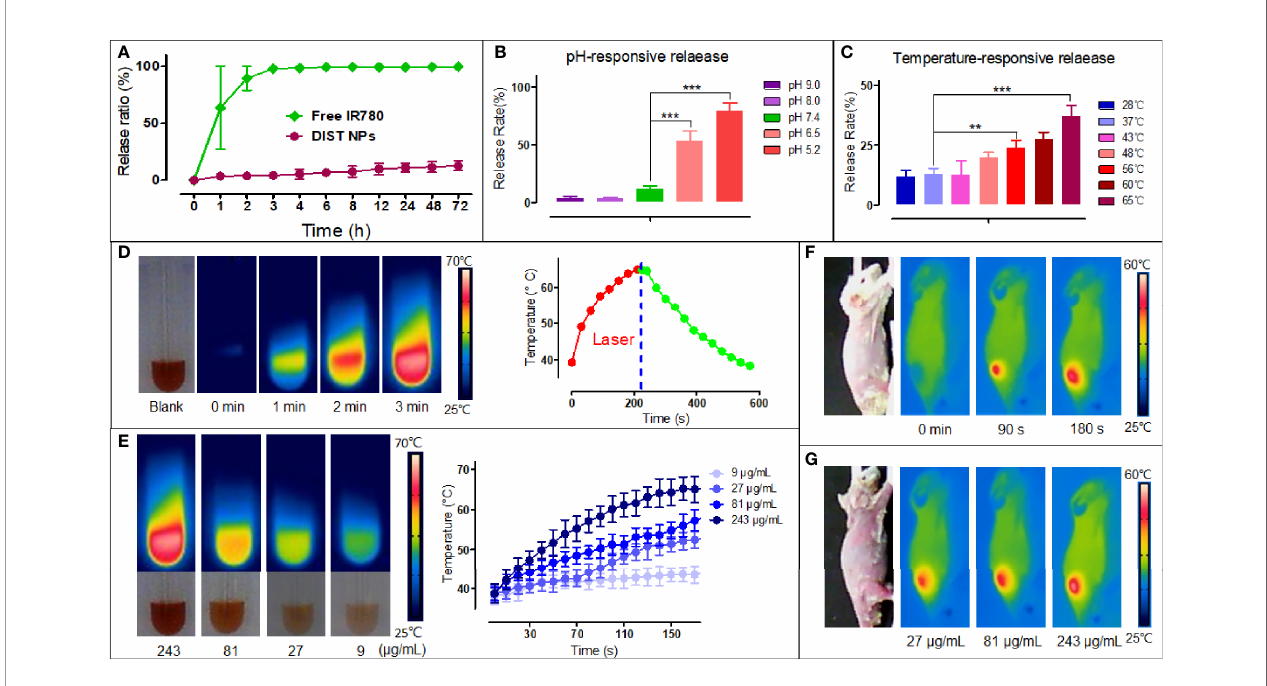
FIGURE 2 | The releasing test results and photothermal properties of the DIST NPs. The IR780 releasing curve of the DIST NPs in the PBS solution with free IR780 as a control (A) . The releasing results of the DIST NPs in different pH environments. The pH 5.2 and 6.5 simulated the pH environments in the lysosome and tumor microenvironment, respectively (B) . The releasing degrees of the DIST NPs under different temperatures. The 65°C and 56°C simulated the maximum temperature that the DIST NPs can get under laser irradiations in vivo and in vitro , respectively (C) . The photothermal conversion results of the DIST NPs (D) . The temperature elevation of the DIST NPs with different concentrations (E) . The temperature elevation of the DIST NPs under the skin of mice. The temperature rise in different irradiation time (F) , and in different injection dose (G) . The quantitative experiment was repeated three times. The ** represents p < 0.01; and ***p <